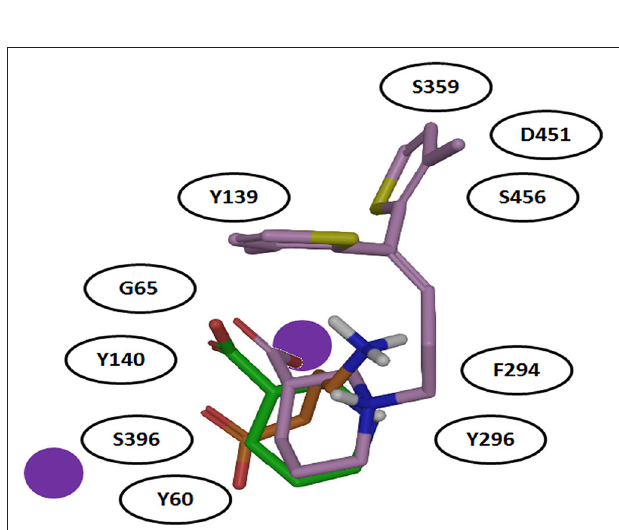
and Tiagabine in GAT1 [taken and modified from Skovstrup et al. (2010)]. All of the three docked ligands have showed ionic interactions with one of the sodium ion present in the GAT1 binding pocket. The aromatic moieties of Tiagabine (purple) face the extracellular vestibule of GAT1 due to the presence of the linker lipophilic